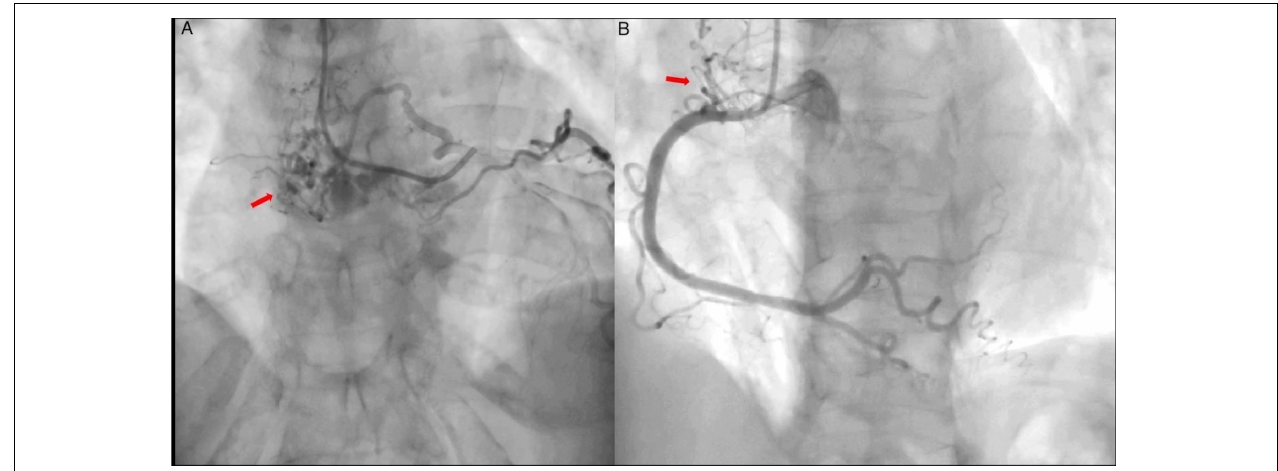
FIGURE 1 | Coronary angiography. (A) Left coronary artery showing abnormal vascular structures (arrow) suggestive of arteriovenous fistula and a highly vascularized mass. Marginal branch demonstrates proximal 90% obstruction ( Supplementary Video 1 ). (B) Right coronary artery shows no obstruction, abnormal vascular structures are also present (arrow).